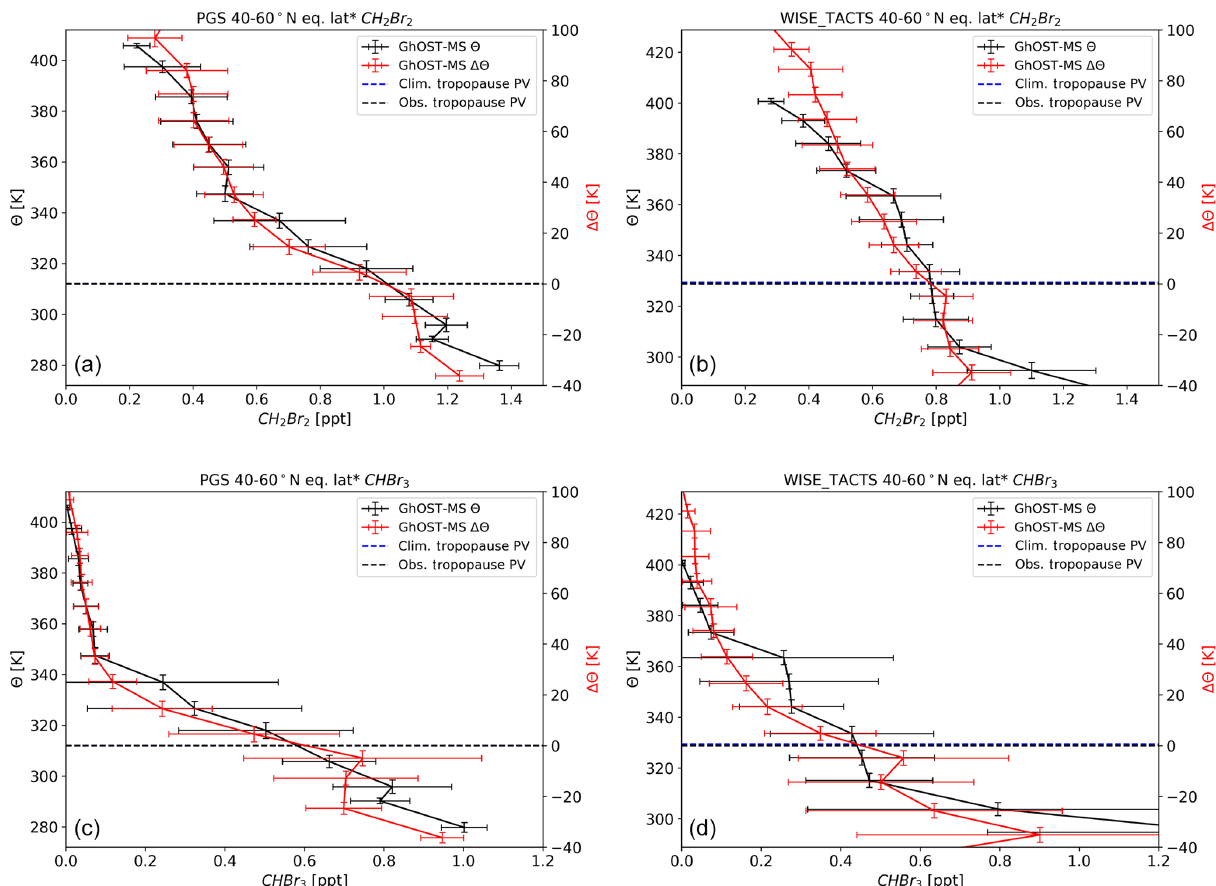
Figure 4. Vertical profiles of CH 2 Br 2 (a, b) and CHBr 3 (c, d) averaged over 40–60 ◦ of equivalent latitude ∗ and all flights during the PGS campaign ( a, c , late December 2015 to March 2016) and from the merged dataset from the TACTS and WISE campaigns ( b, d , representative of late summer to fall). The data are displayed as a function of potential temperature and potential temperature above the tropopause. The dashed blue line shows the zonal mean dynamical tropopause derived from ERA-Interim during September and October of the respective years in the Northern Hemisphere between 40 and 60 ◦ latitude, while the dashed black line is the average dynamical tropopause derived for the times and locations of our observations. Both vertical and horizontal error bars denote 1 σ variability.